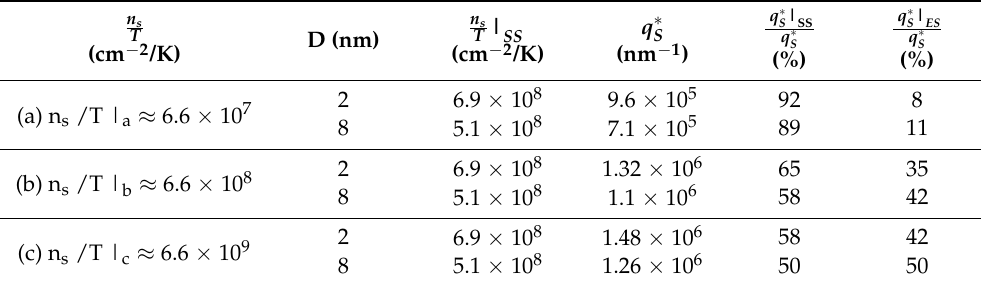
Table 2. Numerical results of the q ∗ n s / T | a ≈ 6.6 × 10 7 cm − 2 / 0 K, n s / T | b ≈ 6.6 × 10 8 cm − 2 / 0 K, n s / T | b ≈ 6.6 × 10 9 cm − 2 / 0 K param- eter values for the InSb/SiO 2 /metal (ll- κ type) multi-layer structure.